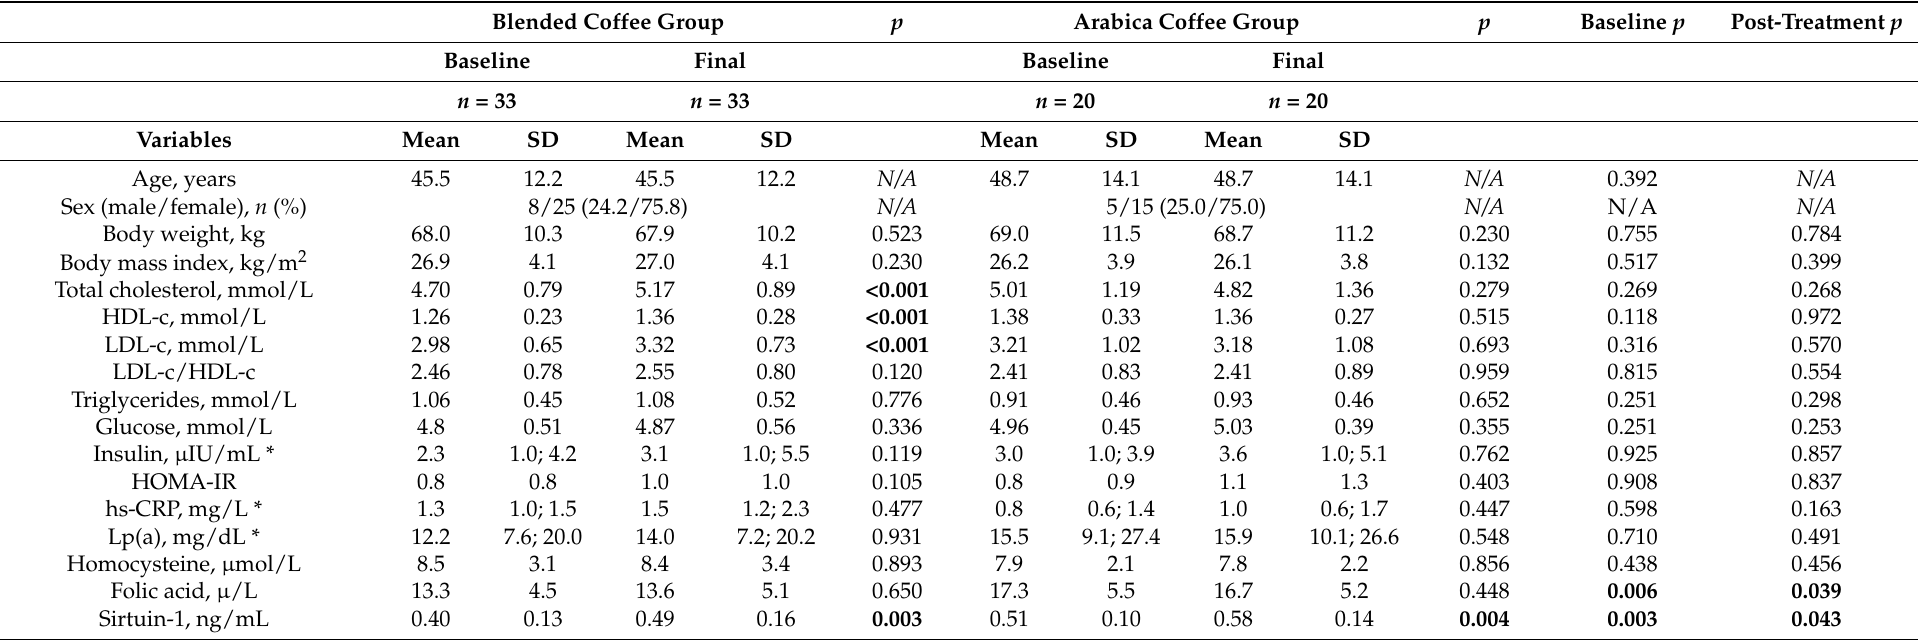
Table 1. Baseline and post-treatment characteristics of the